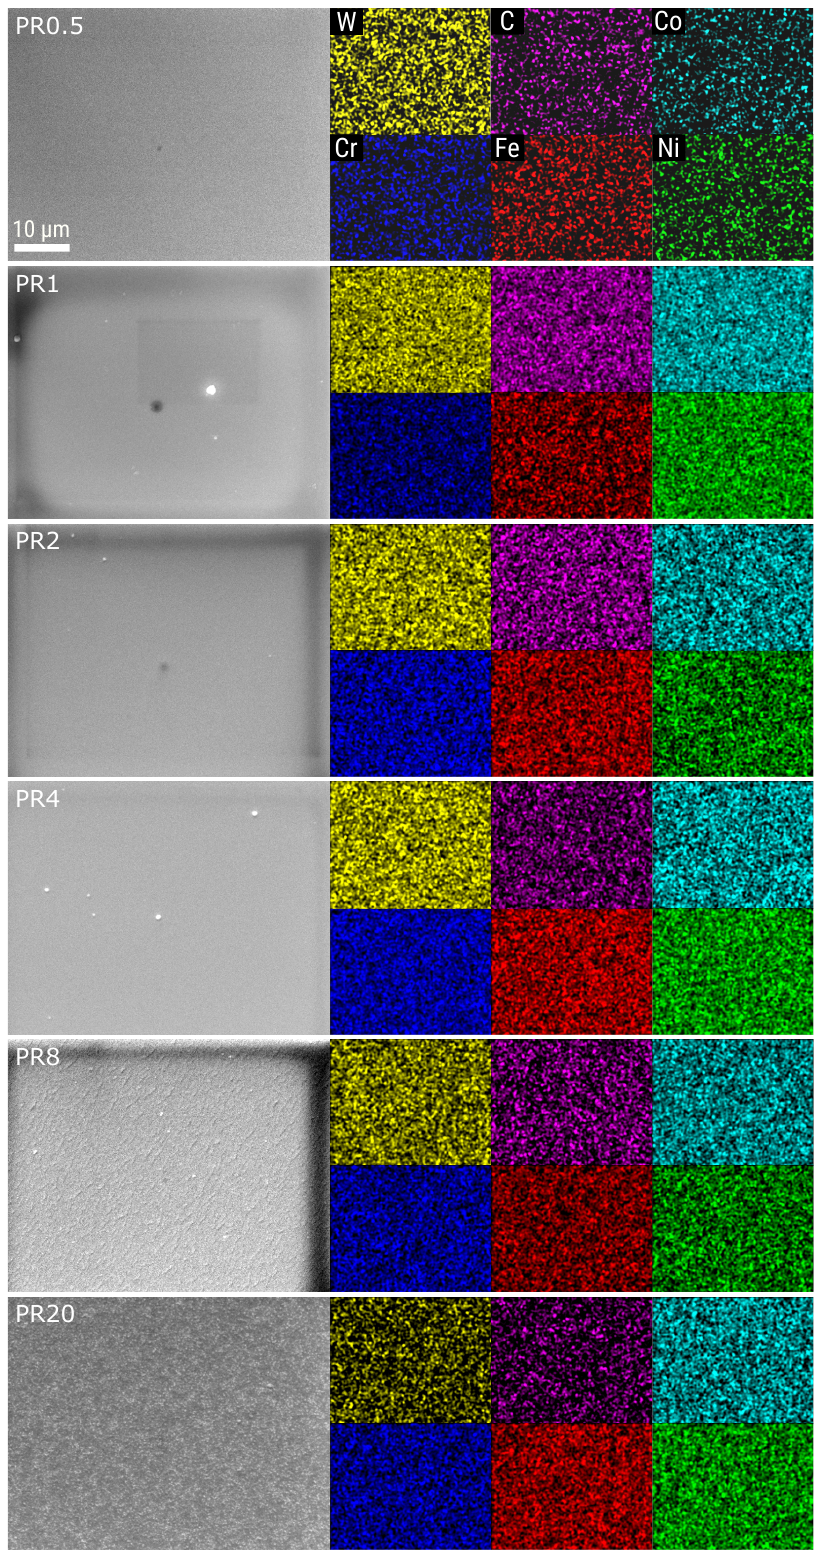
Figure 3. EDX maps and corresponding SE images for the WC-CoCrFeNi mixed thin films prepared by magnetron co-sputtering. The mapped intensities for C, Co, Cr, Fe and Ni belong to the respective K α radiation lines; for W, the L α intensity map is